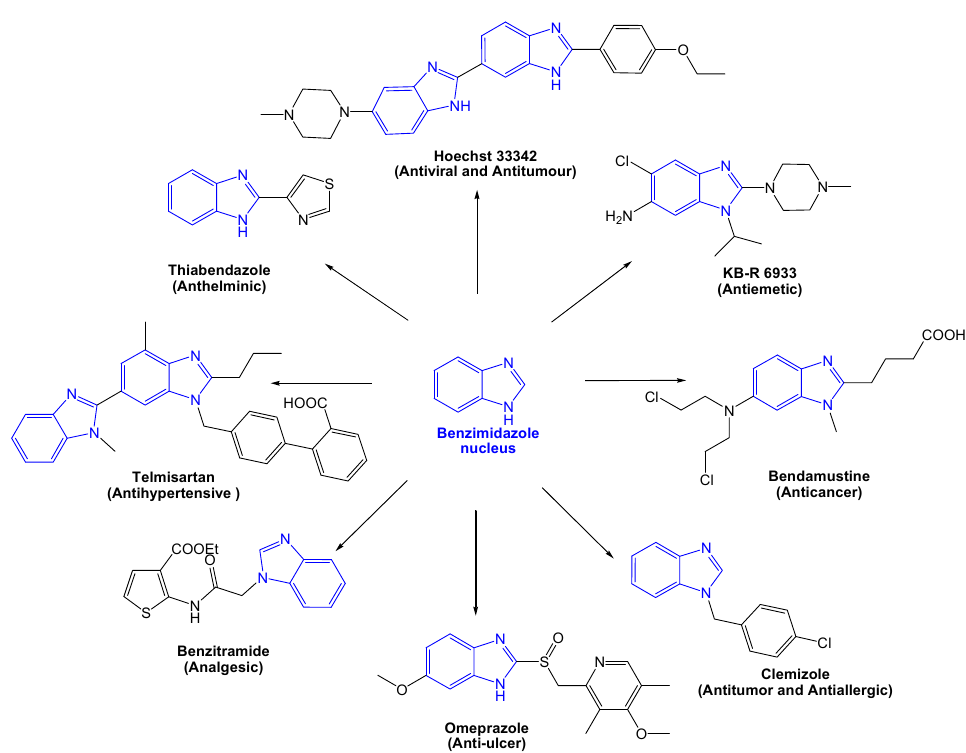
Figure 2. Examples of important drugs containing a benzimidazole nucleus.